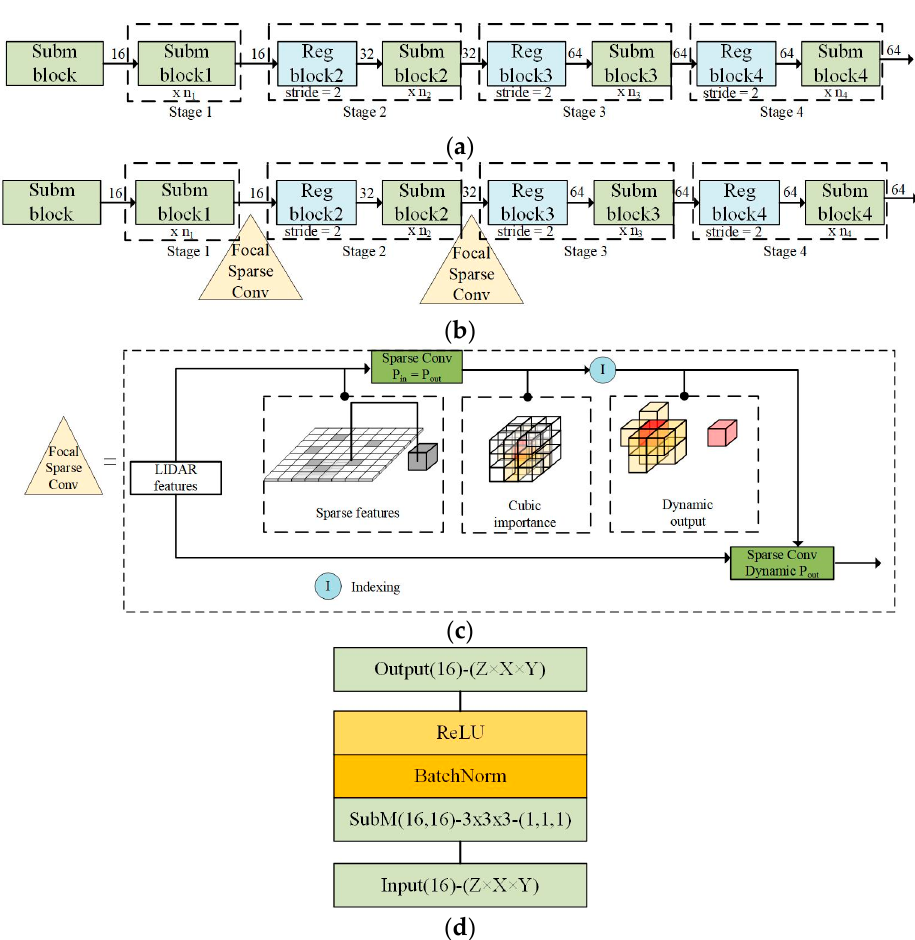
Figure 6. ( a ) Structure of the original 3D backbone. ( b ) Structure of the modified 3D backbone. ( c ) Structure of a focal sparse convolutional network. ( d ) Structure of the Subm block.